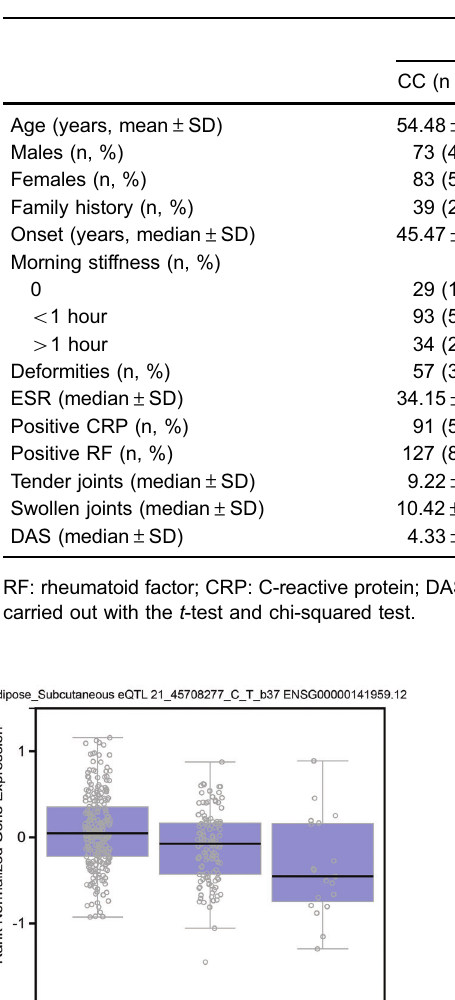
Table 6. Comparison of studied data according to autoimmune regulator (AIRE) genotypes in all rheumatoid arthritis (RA) cases.